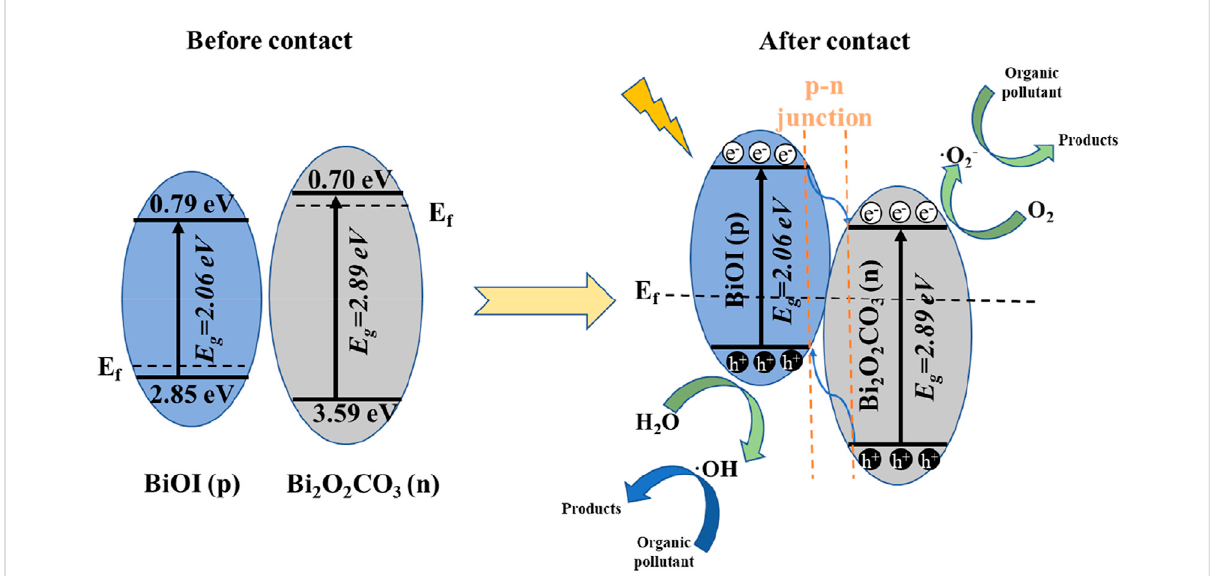
Schematic diagram of the photocatalytic reaction mechanism of Bi 2 O 2 CO 3 /BiOI under visible light